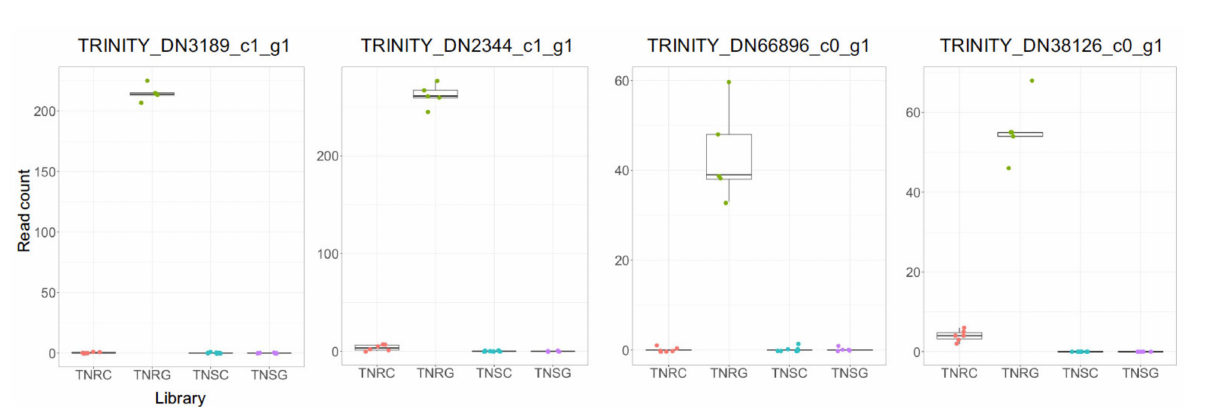
Figure 3. Read count summary of representative genes of upregulated genes in TNR but not in TNS after glyphosate treatment. These genes were selected from the genes listed in Table